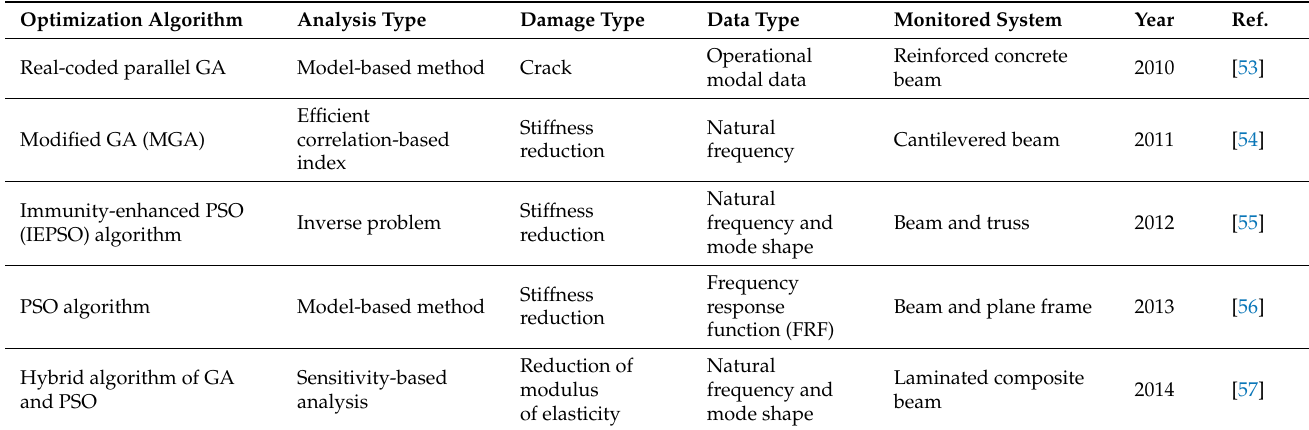
Table 4. Papers on optimization algorithms used for SDD (between